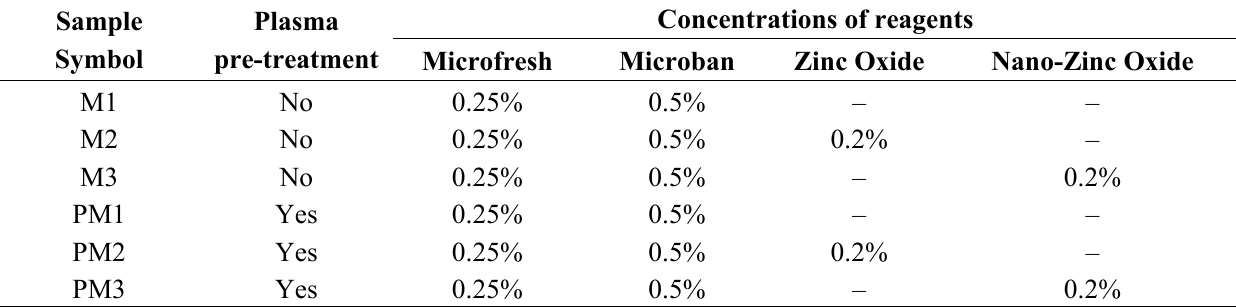
Table 1. Antimicrobial treatment